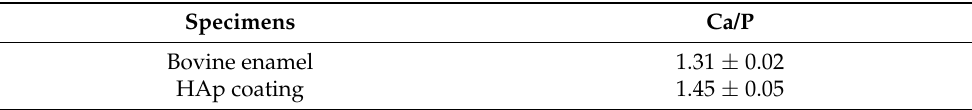
Table 2. Calcium-to-phosphorous (Ca/P) ratio of bovine enamel and hydroxyapatite film coating. ( n =